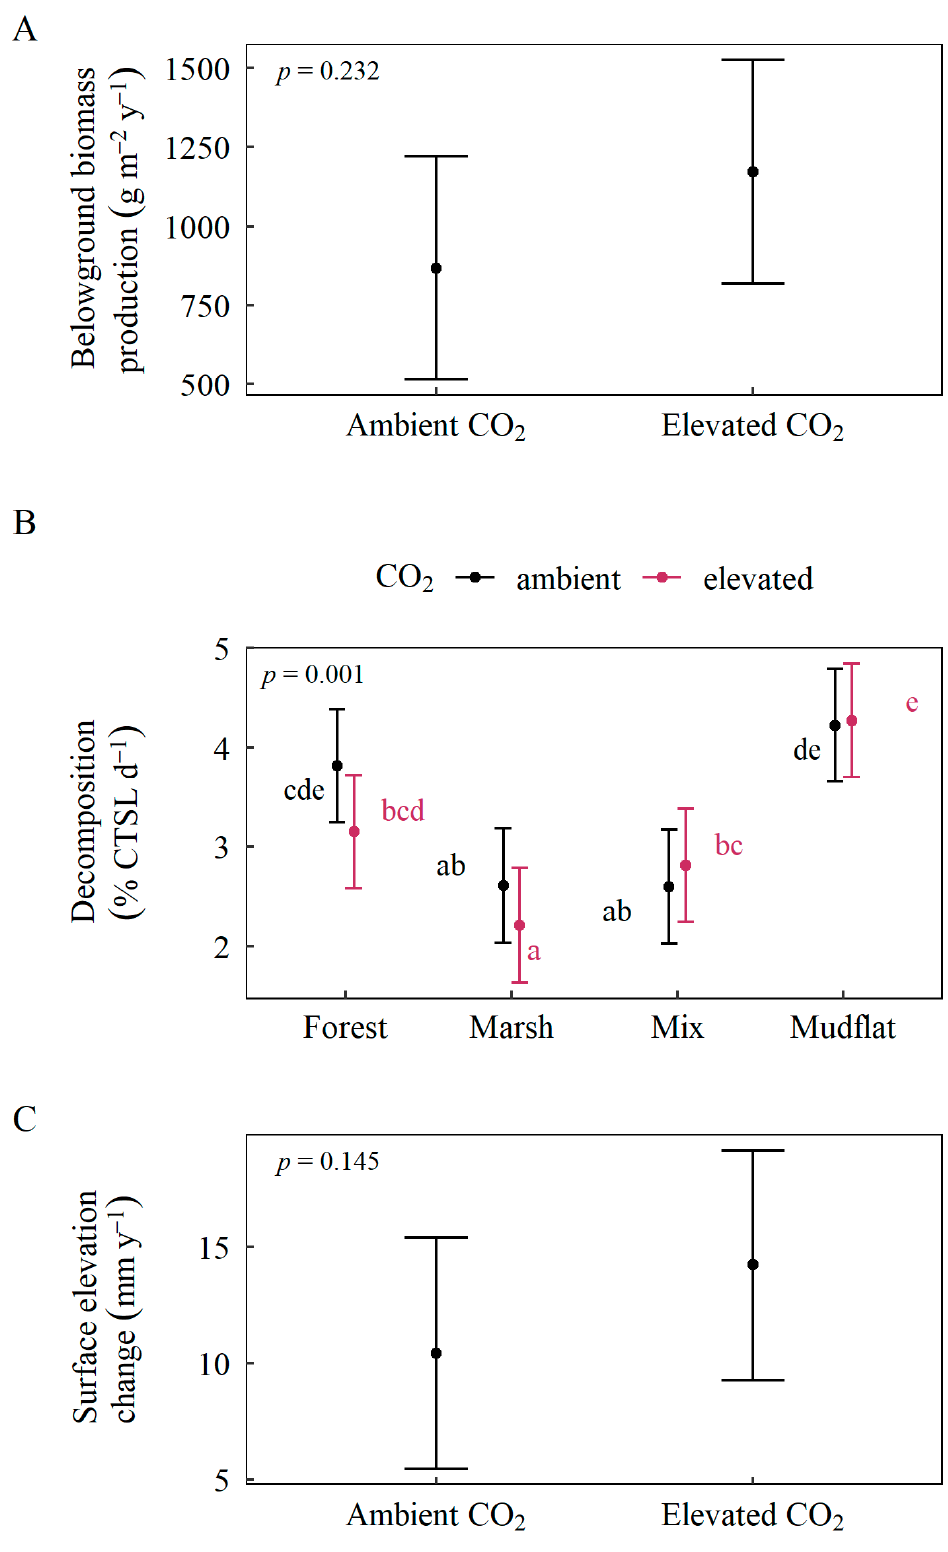
Figure 4. Effects of elevated atmospheric CO 2 and community interactions, where significant, on all response variables: ( A ) belowground biomass production, ( B ) decomposition, ( C ) surface elevation change rate. Response variable values are model-based estimated marginal means using Satterthwaite approximation. Brackets represent 95% confidence intervals; letters represent significant differences determined by Tukey’s ( p < 0.05) post hoc comparisons.